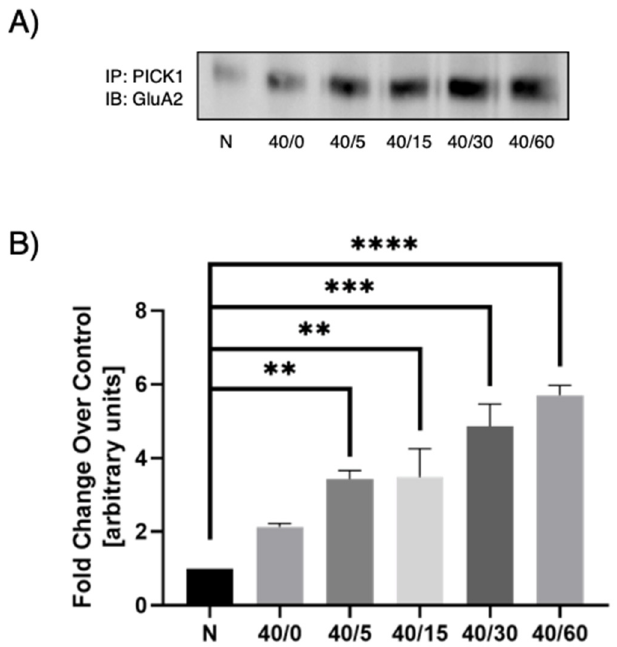
Figure 4. OGD/R-induced PICK1–GluA2 interaction increases with reperfusion time. Post-OGD/R immunoprecipitation of PICK1 and subsequent immunoblotting for GluA2 show an increase in PICK1–GluA2 interaction in hippocampal slices at 40 min of OGD and 5, 15, 30, and 60 min of reperfusion. ( A ) Representative Western blot of GluA2 following immunoprecipitation of PICK1 at indicated OGD/R time-points. ( B ) Quantification of Western blots normalized to normoxic control. N = 3, one-way ANOVA with post hoc Sidak, ** denotes p < 0.01, *** denotes p < 0.001, **** denotes p < 0.0001, data are expressed as mean ± standard error of the mean (SEM).